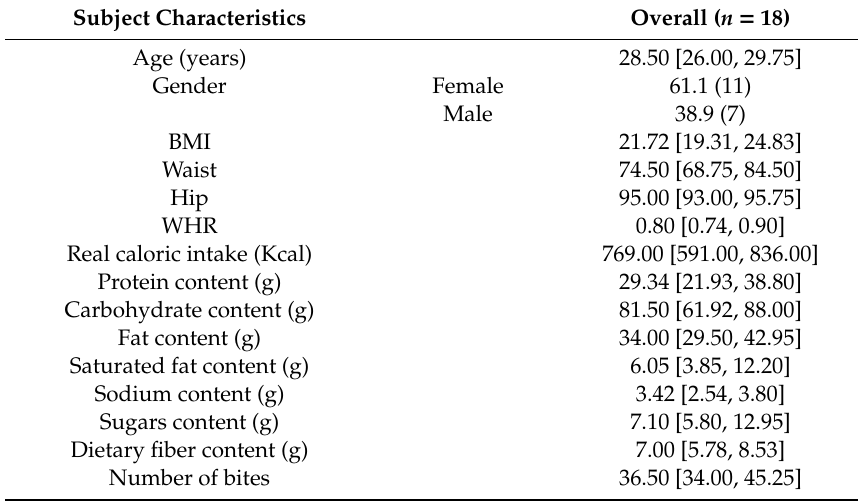
Table 3. Descriptive statistics of subjects enrolled in the study. Continuous variables are reported as medians [I and III quartiles], and categorical variables are reported as percentages (absolute